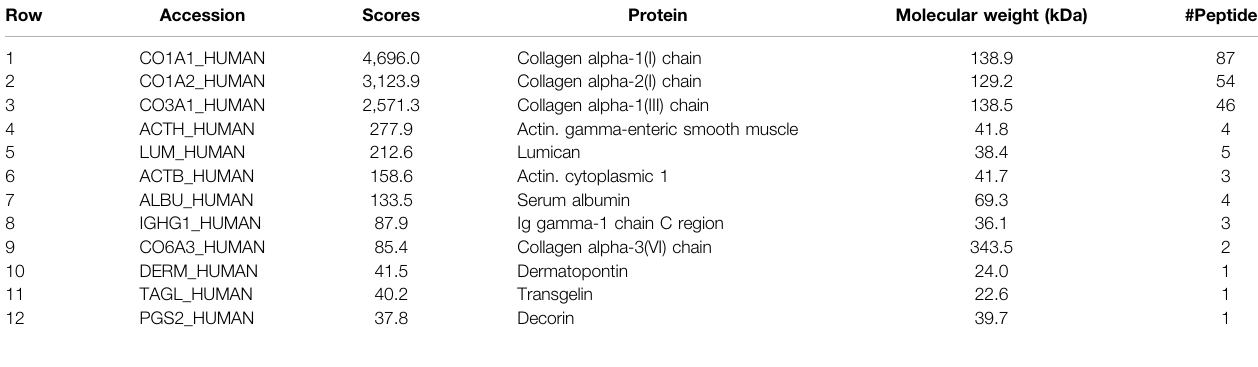
TABLE 1 | Protein content identi fi ed by mass spectrometry analysis of the WJ-ECMaa pool. Results represents the mean of the values obtained for the three pools of WJ- ECMaa.